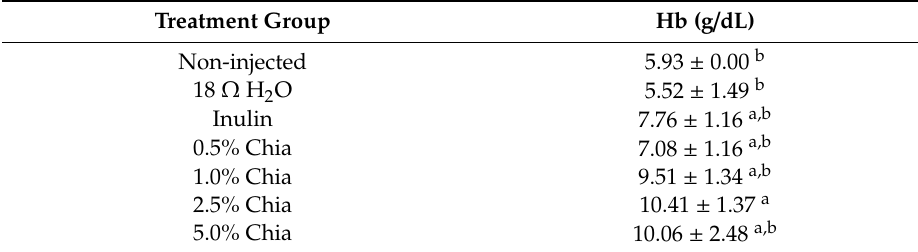
Table 4. Blood hemoglobin (Hb) concentrations (g / dL).